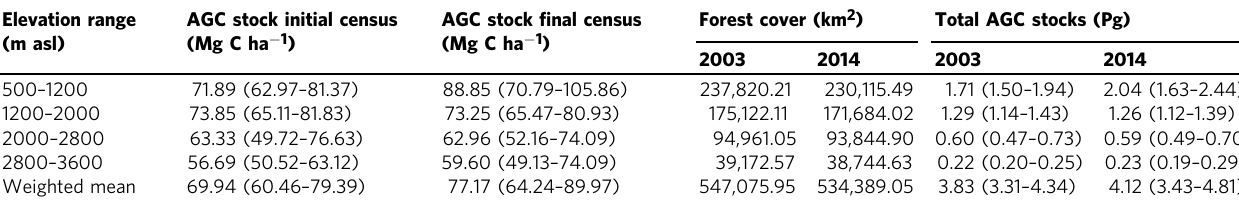
AGC stocks are estimated at initial and fi nal censuses multiplied by forest area for 2003 and 2014, respectively (mean and bootstrapped 95% CI) (see Main text). The total C forest stock is the total estimatedamountforeachelevationalbandandthewholesubtropicalandtropicalAndeanregion.Theweightedmeanrepresentstheoverallmeanweightedbyforestcoveraccordingtoeithertheinitial (2003) or fi nal (2014)